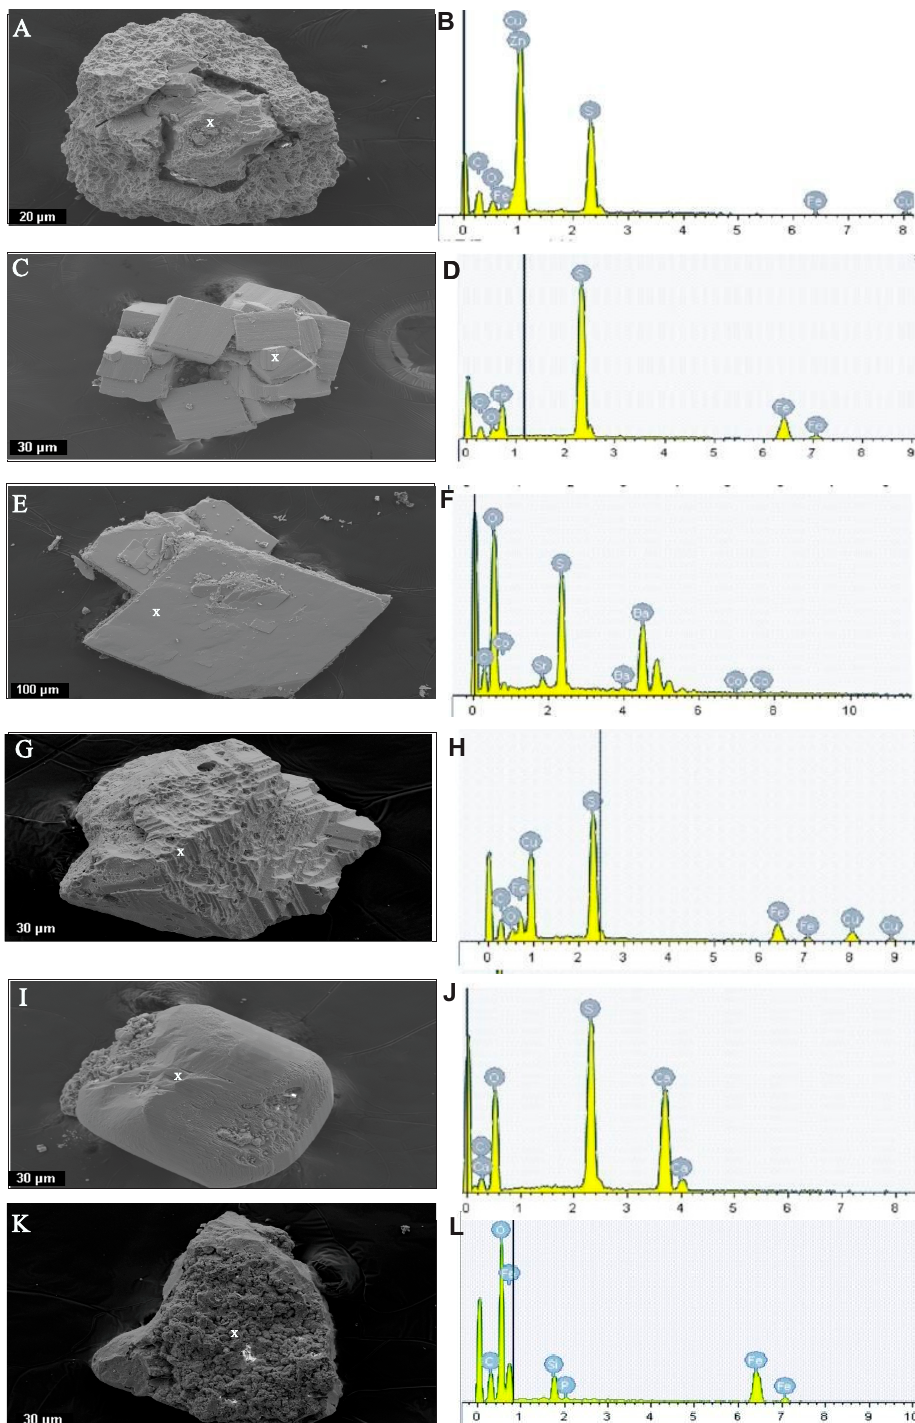
Figure A1. SEM photomicrographs and EDS spectra of typical sulfide, sulfate, and oxyhydroxides. ( A , B ) sphalerite separates and EDS spectrum; ( C , D ) pyrite separates and EDS spectrum; ( E , F ) barite separates and EDS spectrum; ( G , H ) chalcopyrite separates and EDS spectrum ( I , J ) anhydrite separates and EDS spectrum; ( K , L ) Fe-oxyhydroxide separates and EDS